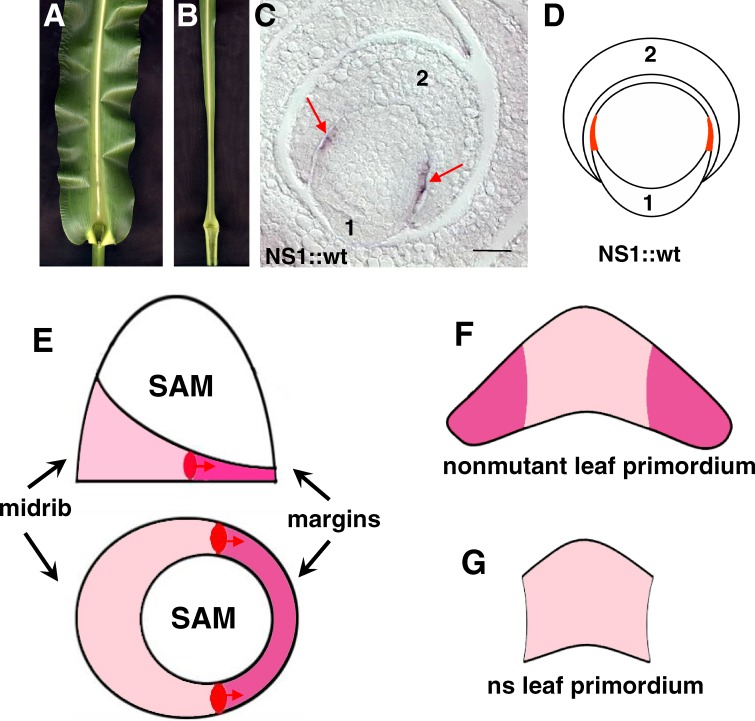
NS Mutants Delete Lateral Leaf Domains Due to Loss of NS Function in Lateral Foci of the SAM(A and B) The ns mutant leaf (B) contains a developmental deletion of a large lateral domain present in nonmutant leaves (A). In situ hybridization reveals NS1 transcript accumulation (C) and modeled in (D) in two lateral foci during initiation of a new leaf primordium (1) from the SAM.(E) Drawings of leaf initiation from the SAM are depicted in longitudinal (top) and transverse (bottom) sections. Leaf founder-cell initiation begins on one SAM flank that gives rise to the midrib and central domain of the leaf primordium (faint pink in [E–G]). NS1 function (red arrows in [E]) is required to complete founder cell recruitment of lateral domains of the leaf that includes the margin (dark pink in [E and F]). Loss of the NS1 recruitment function results in failure to recruit this lateral leaf domain (B) and (G). Images in (A, B, and C) are reproduced with permission from Nardmann et al. [2].